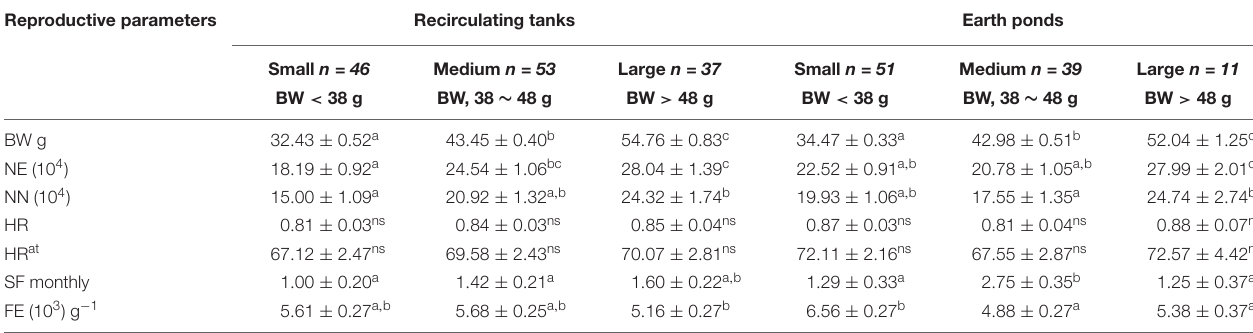
TABLE 2 | Comparison of mean reproductive performance ( ± 1 SE) of different size classes of female broodstock reared in earthen ponds (EP) vs recirculating tanks (RT). Reproductive parameters